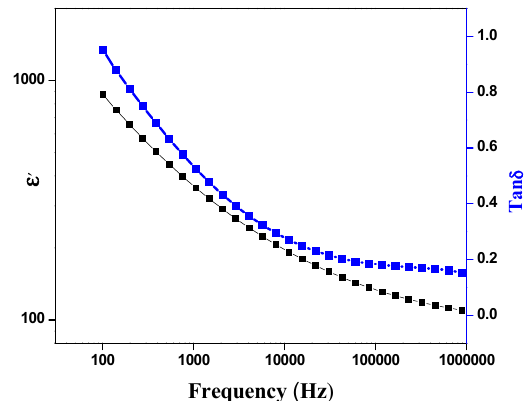
Figure 5. Variation of dielectric constant ( ɛ ) and dielectric loss ( έ ) with frequency.